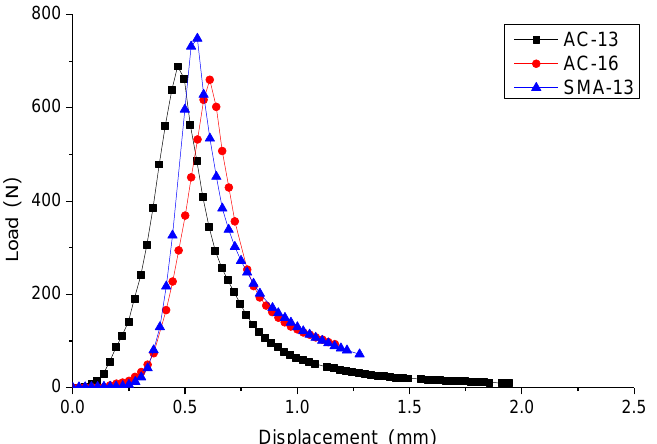
Figure 6. Load-displacement diagram of asphalt mixture beams with a notch depth of 8 mm.